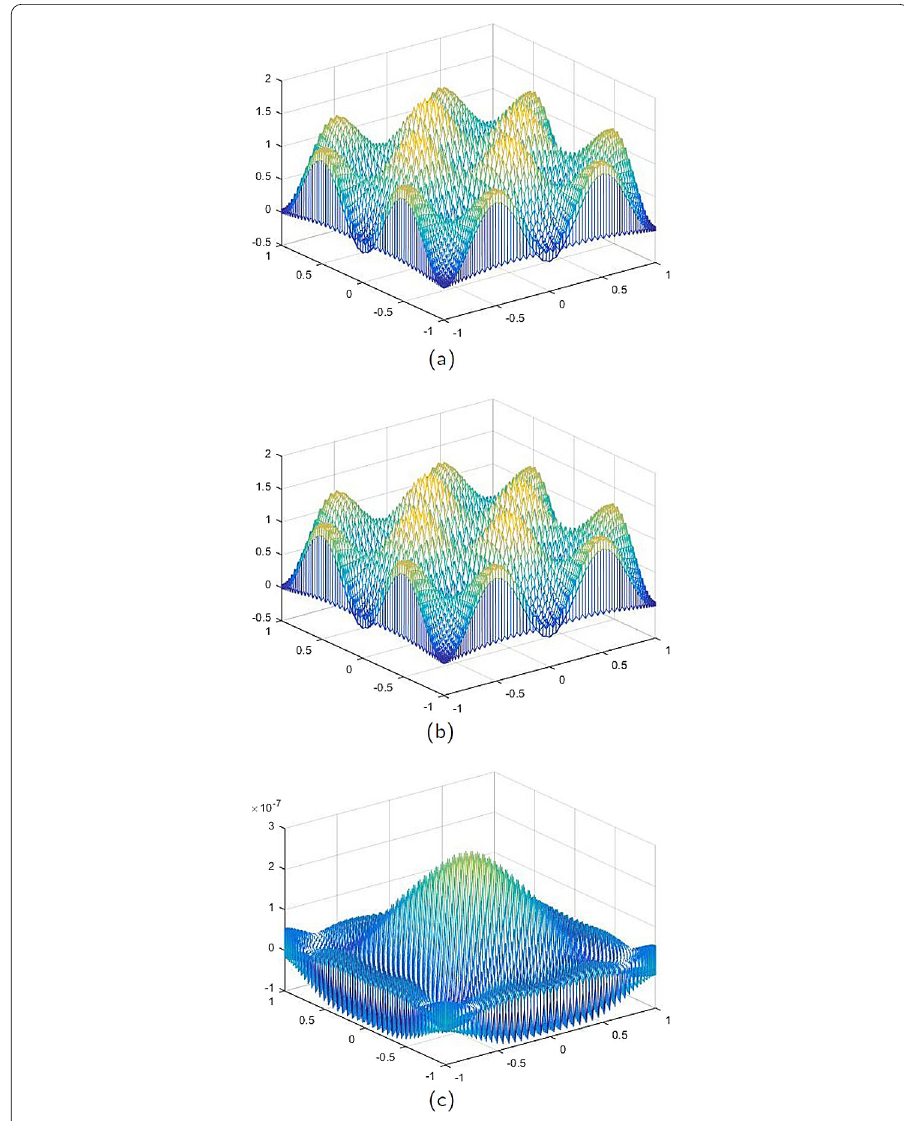
Figure 2 (a) The CNCS solution when t = 0.3. (b) The analytical solution when t = 0.3. (c) The errors between the analytical solution and CNCS solution at t = 0.3